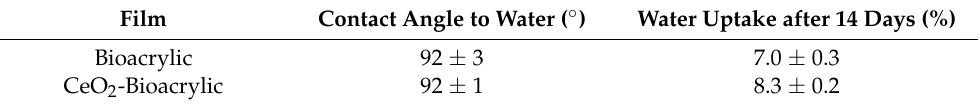
Figure 4. Water uptake experiment results of neat polymer film and the hybrid one. Table 3. Water sensitivity of the neat polymer film and the hybrid one.